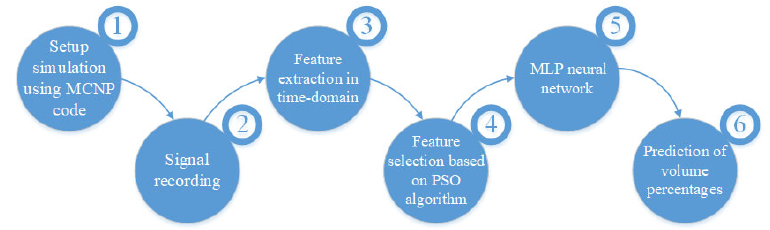
Figure 1. Flowchart of proposed methodology.